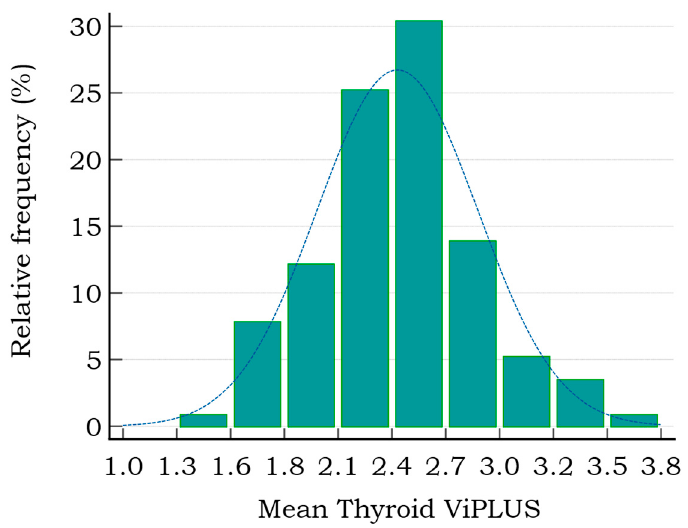
Figure 2. The distribution of thyroid mean Vi PLUS values in healthy subjects (range 1.3–3.8 Pa · s). The mean ViPLUS values for both thyroid lobes were compared for each subject (median of 5 values for each lobe). A mean value of 2.42 ± 0.44 Pa · s was determined for the left thyroid lobe (LTL) measurements and a mean of 2.43 ± 0.44 Pa · s for the right. No significant differences were found between the left (LTL) and right thyroid lobe (RTL) (Figure